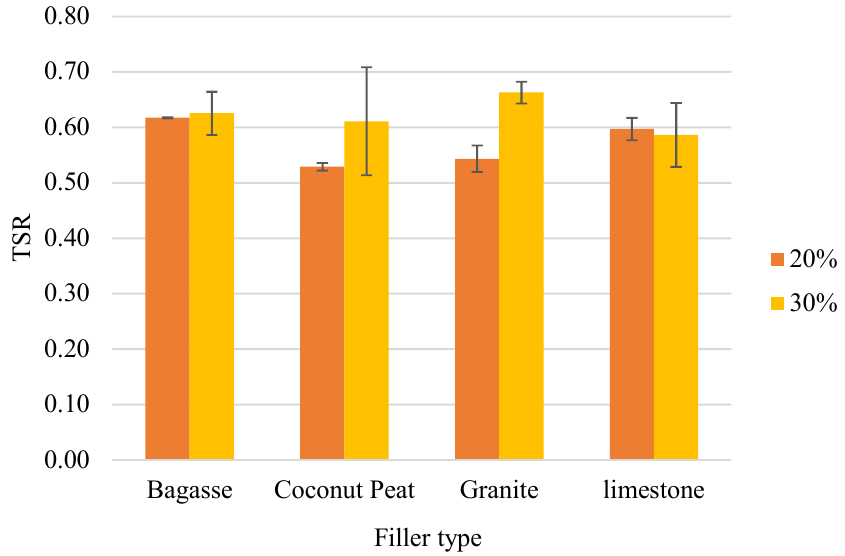
Figure 7. TSR of ITS test after moisture of asphalt mixtures with granite aggregate for all filler types.